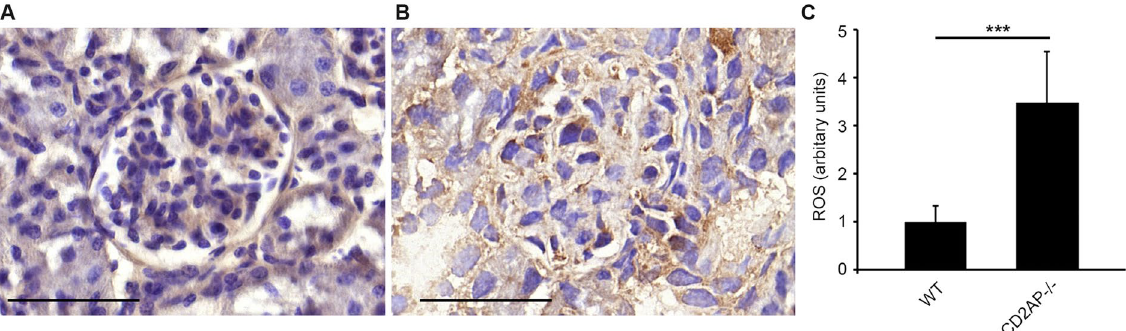
Figure 4. Absence of CD2AP in mouse kidneys leads to an increase in ROS. ( A ) Representative image of a 3 weeks old wild type mouse kidney section stained with anti-8-OHdG IgG. ( B ) Representative image of a 3 weeks old CD2AP − / − mouse kidney section stained with anti-8-OHdG IgG. ( C ) Quantification reveals 3.5- fold increase in 8-OHdG staining in glomeruli of CD2AP − / − mice reflecting oxidative damage to DNA and RNA. Scale bar ( A , B ): 40 µ m. In ( C ), the bars show the difference in arbitrary units between relative mask areas quantified with the HistoQuant module (error bars SEM). *** p < 0.001, Student’s